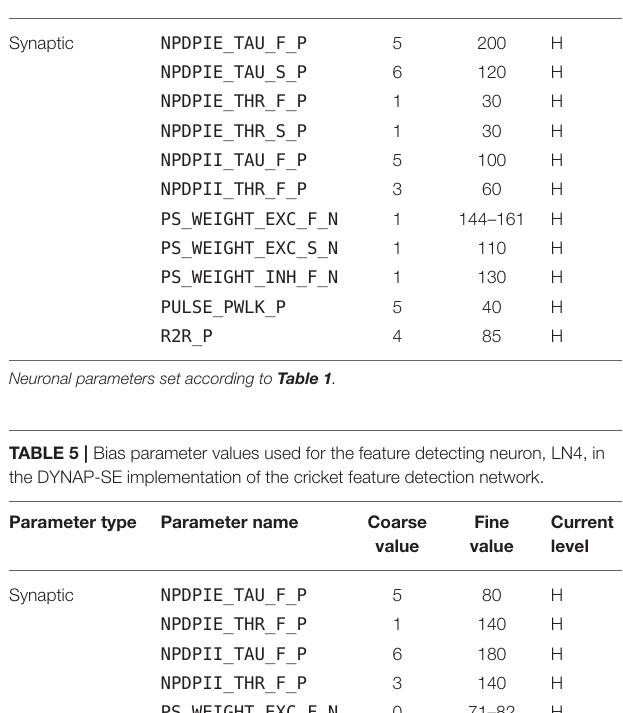
TABLE 4 | Bias parameter values used for the coincidence detecting neuron, LN3, in the DYNAP-SE implementation of the cricket feature detection network. Parameter type Parameter name